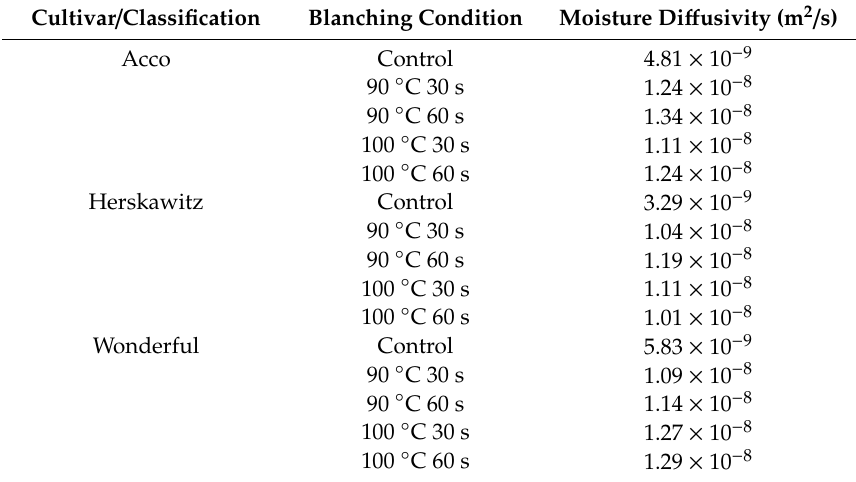
Table 2. Moisture e ff ective di ff usion ( De ff ) of dried pomegranate aril under di ff erent blanching conditions for di ff erent